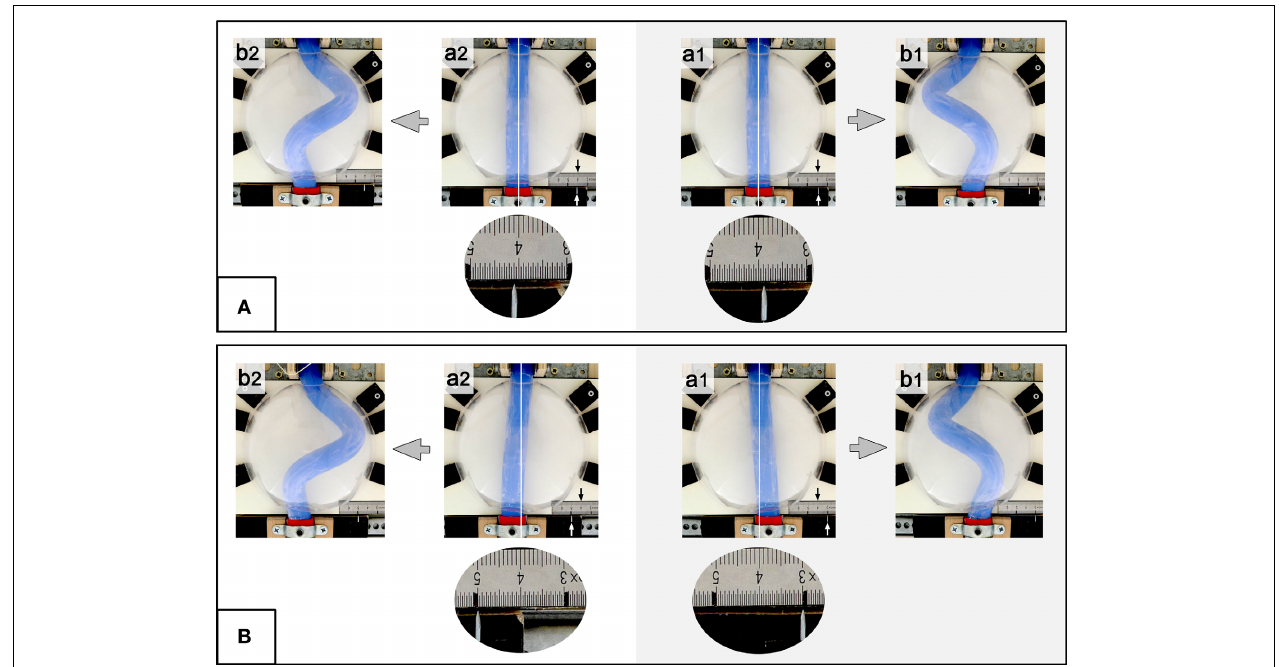
FIGURE 9 | These photographs taken at frontal views show examples of buckling tests conducted under asymmetric conditions (experiment 3: left- or rightward displacement of the “caudal” end of the silicone rod). (A) 1mm lateral displacement before running of the buckling experiment. (B) 10mm lateral displacement before starting the buckling experiment. Note that pre-buckling displacement toward the left (a1)